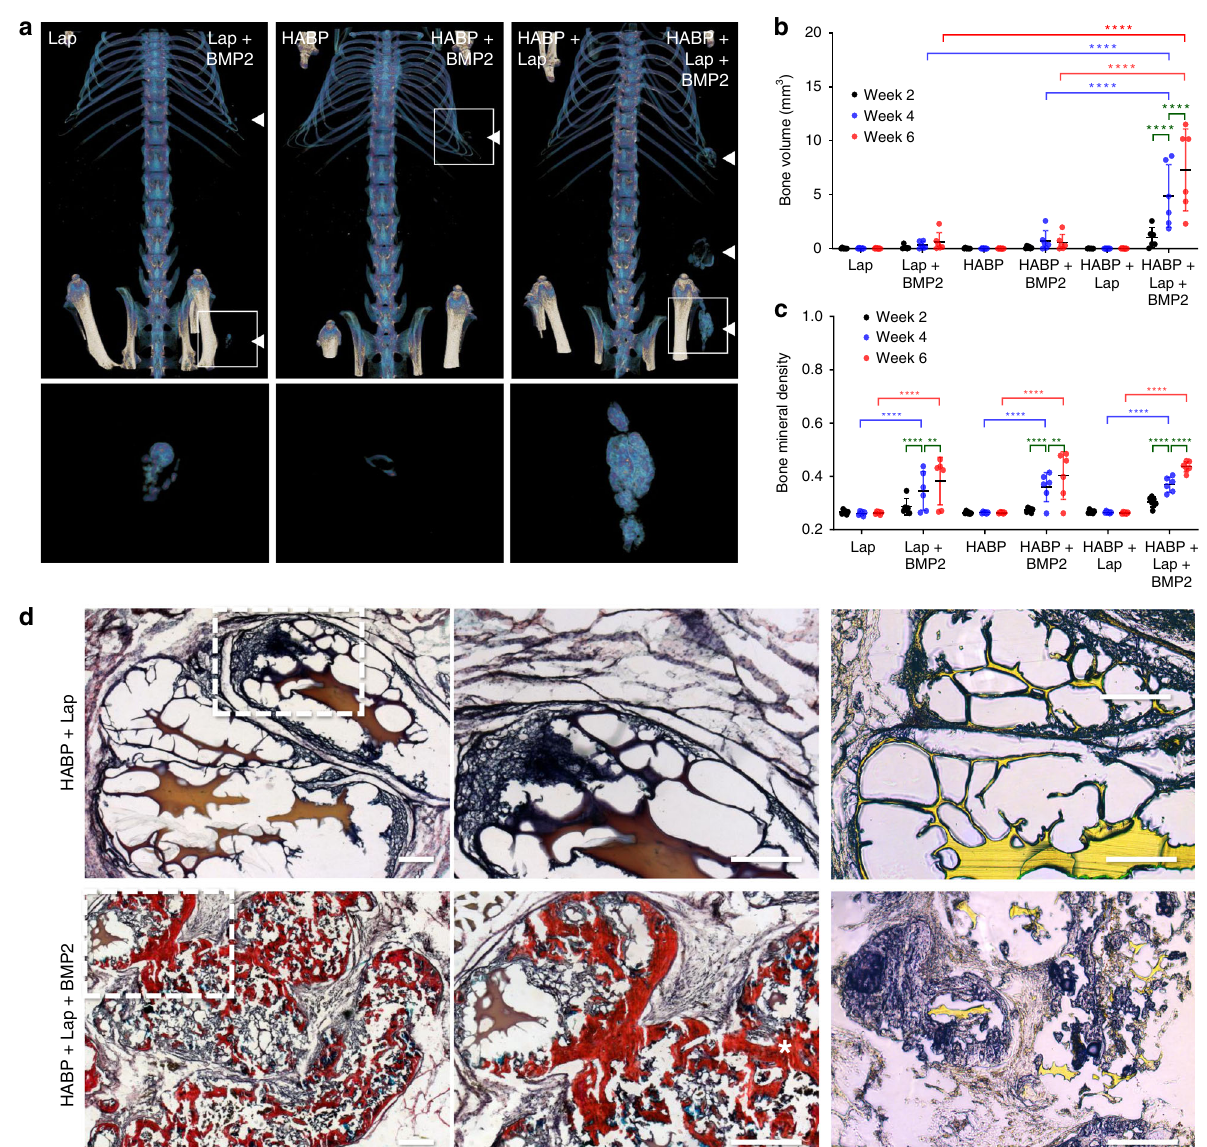
Fig. 6 Bisphosphonate-tethered Laponite sustains retention of functional BMP-2. Laponite, HABP, and HABP + Laponite were loaded with low doses (5 µ g ml − 1 ) and implanted subcutaneously in mice to assess ectopic bone induction. False color μ CT reconstructions of ectopic bone 6 weeks post implantation ( a ). HABP + Laponite delivered BMP-2 to induce signi fi cantly higher volumes of bone compared to either HABP or Laponite alone and sustained a signi fi cant increase in both bone volume ( b ) and density ( c ) over 6 weeks (error bars = standard deviation, n = 6; **, *** and **** indicate P values of 0.01, 0.001, and 0.0001, respectively, two-way Anova, Tukey ’ s multiple comparisons test). Histological analysis of the recovered hydrogels revealed extensive regions of Sirius red stained bone tissue only in HABP + Laponite hydrogels incorporating BMP-2 ( d ). Auramine O staining (yellow) of Laponite indicates extensive degradation of the hydrogel structure with addition of BMP-2 ( d ). Scale bar = 50 µ normal force (0.015 N) and a fi xed strain. Frequency oscillation sweep from 0.1 to derivative (HA-hy) was used, whereas to obtain the hydrogels from groups 3 and 4, 10 Hz was performed by monitoring storage ( G ′ ) and loss moduli ( G ′′ ) at fi xed HA dually modi fi ed with hydrazide and BP groups (BP-HA-hy) was used. Firstly, strain of 1%. Strain oscillation sweep from 0.2 to 100% was performed by mon- solutions of Laponite and the HA components in water were prepared at 4% and itoring storage ( G ′ ) and loss moduli ( G ′′ ) at fi xed frequency of 0.5 Hz. Time 3%, respectively. The HA + Laponite and HABP + Laponite hydrogels of 0.3mL oscillation sweep was performed by applying strain at low (0.2%) and high (50%) volume were obtained by mixing of 25 μ L of water with 75 μ L of Laponite, 100 μ L values in an alternating manner but at the fi xed frequency of 0.5Hz. All experi- of HA-al, and 100 μ L of hydrazide component (either HA-hy or BP-HA-hy) ments were repeated three times. Rheology plots represent measurements taken subsequently. For preparation, of HA and HABP hydrogels, Laponite was sub- from the same sample. Mechanical properties were studied for as prepared stituted with water. The mixtures were quickly transferred into syringe molds to hydrogels as well as after their equilibrium swelling in PBS for 24h. For scanning prevent evaporation and kept overnight, as described for the preparation of phy- electron microscopy (SEM) analysis hydrogels were freeze-dried and coated with sical hydrogels. 8 – 10nm of Au/Pd before analysis on SEM (LEO 1550, Zeiss). Hydrogel characterization . Rheological characterizations of all hydrogels were In vitro release of proteins and degradation of hydrogels . In vitro release of performed using an AR2000 Advanced Rheometer (TA Instruments) with alu- lysozyme (egg white) and albumin (bovine serum) from hydrazone cross-linked minum parallel plate geometry of 8 mm diameter. Frequency sweeps from 0.1 to HABP hydrogels with or without Laponite and their degradation were evaluated. 10Hz were performed by monitoring storage ( G ′ ) and loss moduli ( G ′′ ) at a fi xed